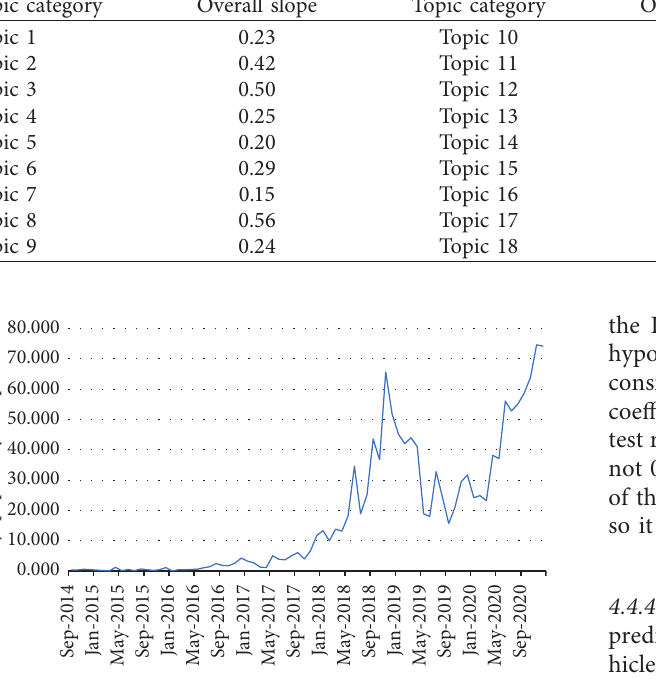
Figure 10: Timing diagram of popularity of Topic